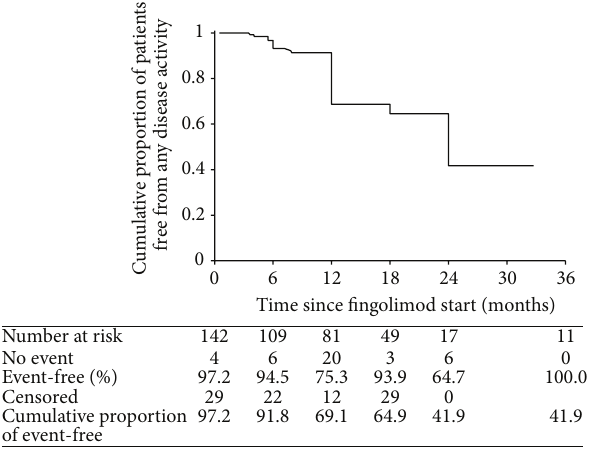
Figure 6: Kaplan-Meyer plot of cumulative proportion of patients remaining free from any disease activity over time from start of fingolimod